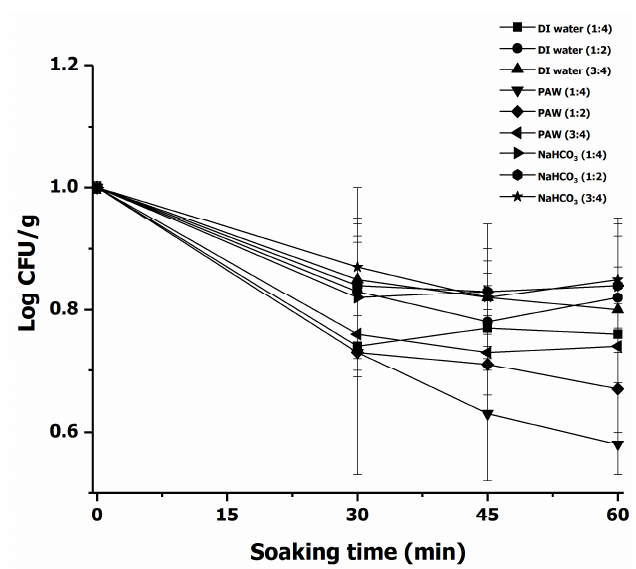
Figure 8. Effect of ratio of chili and mediums (DI water, PAW, and NaHCO 3 ) on E. coli inactivation with different treatment time in chili.